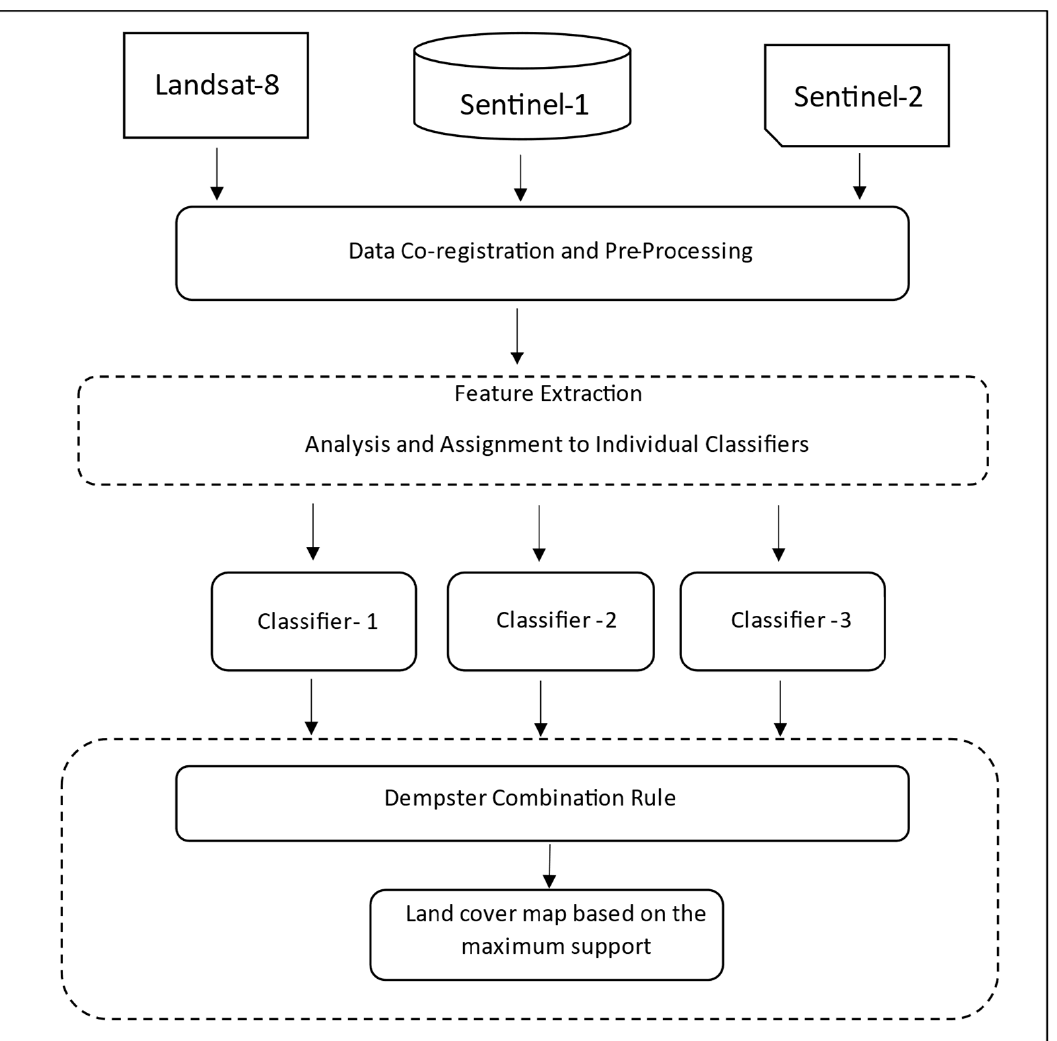
Figure 3. Workflow of the proposed ensemble classifier combining the results of three different classifiers based on D–S theory .